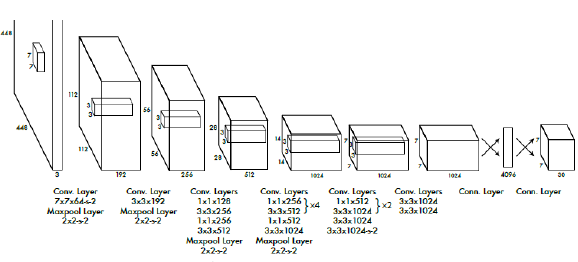
Figure 3. Framework of